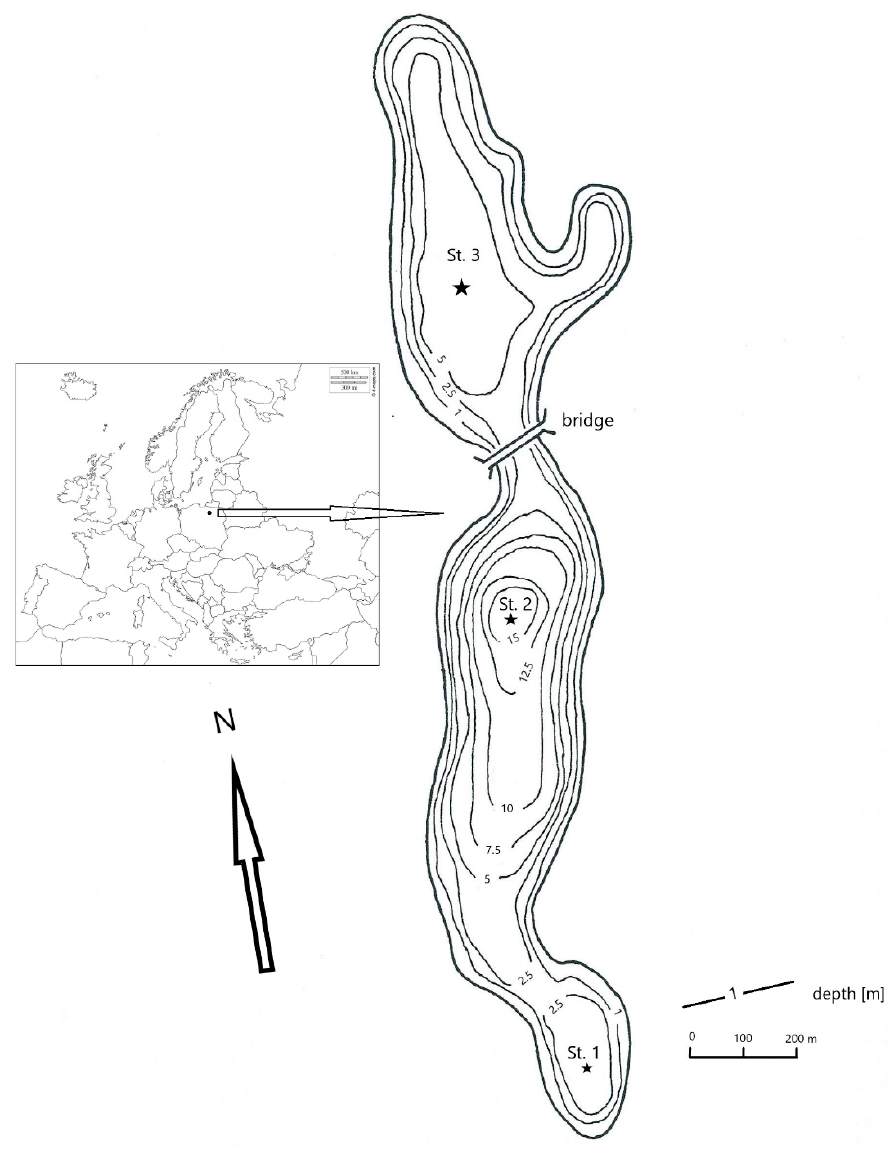
Figure 1. Location of research stations on Długie Lake (source: Inland Fisheries Institute in Olsztyn, d-maps.com).